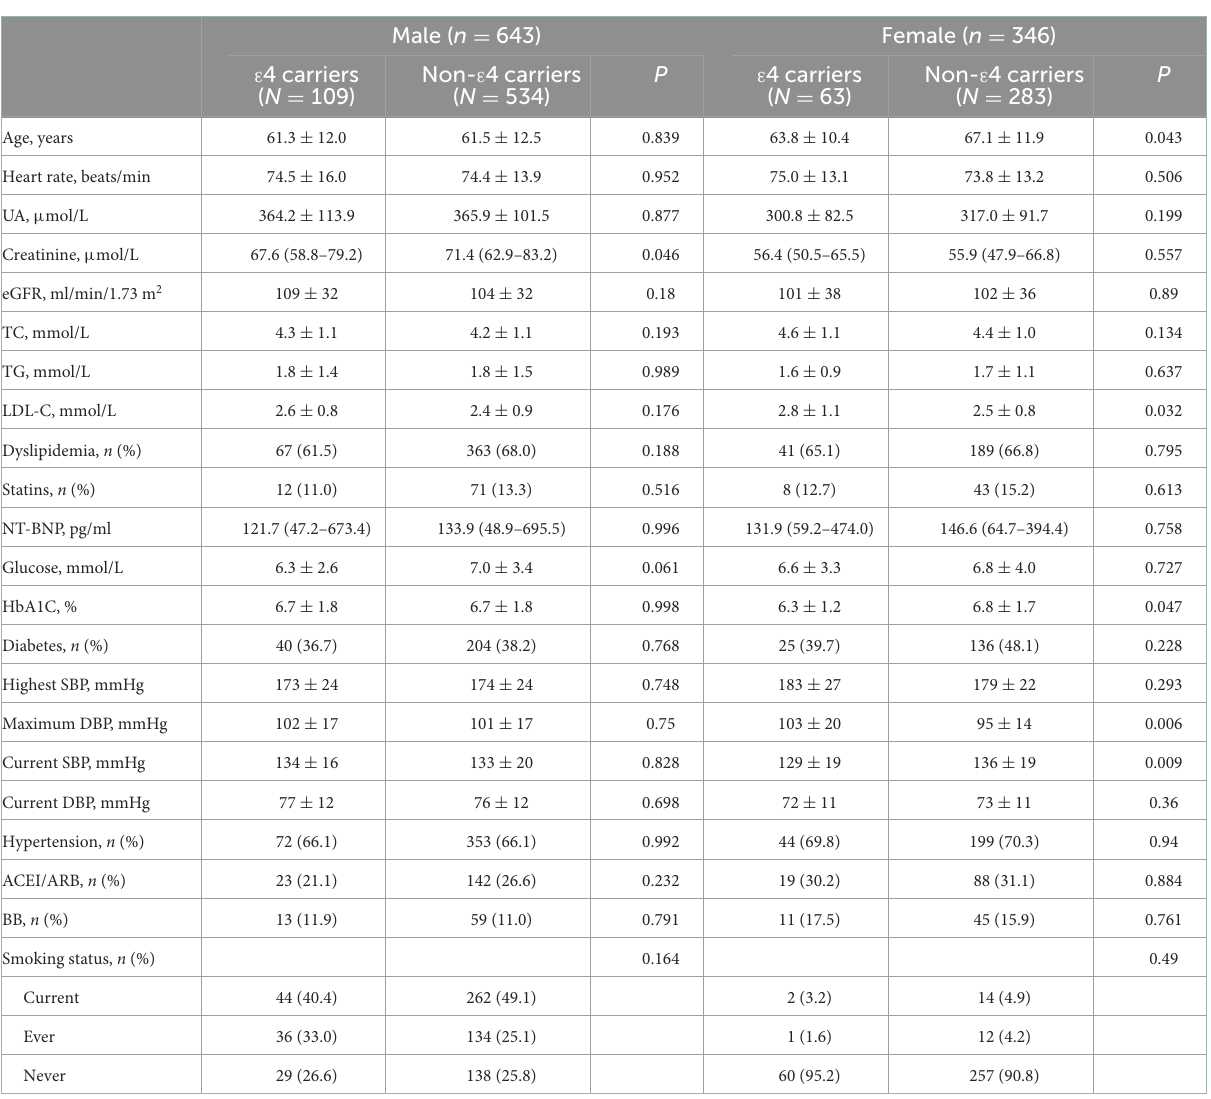
TABLE 1 Characteristics of the study